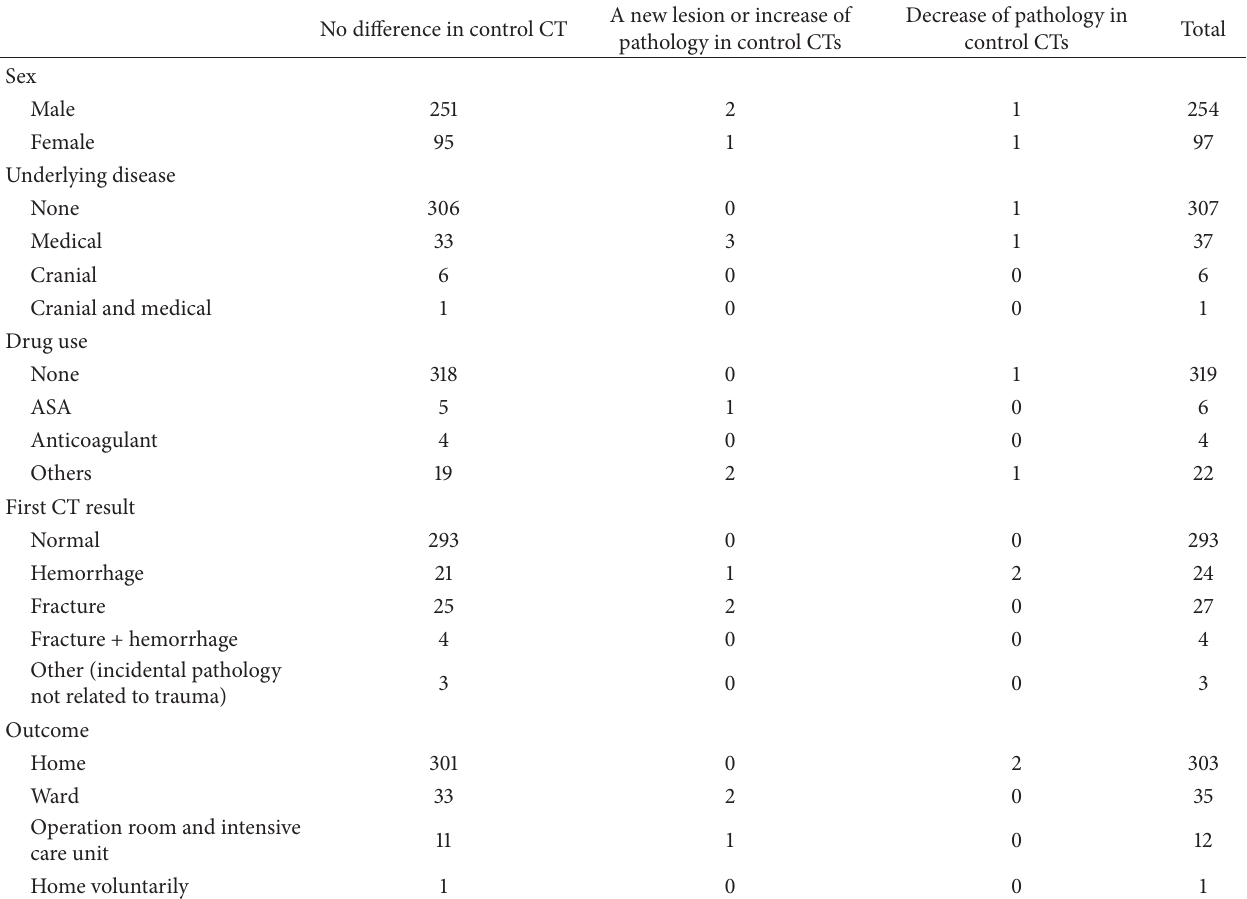
Table 1: General characteristics of patients who had control cranial CTs.